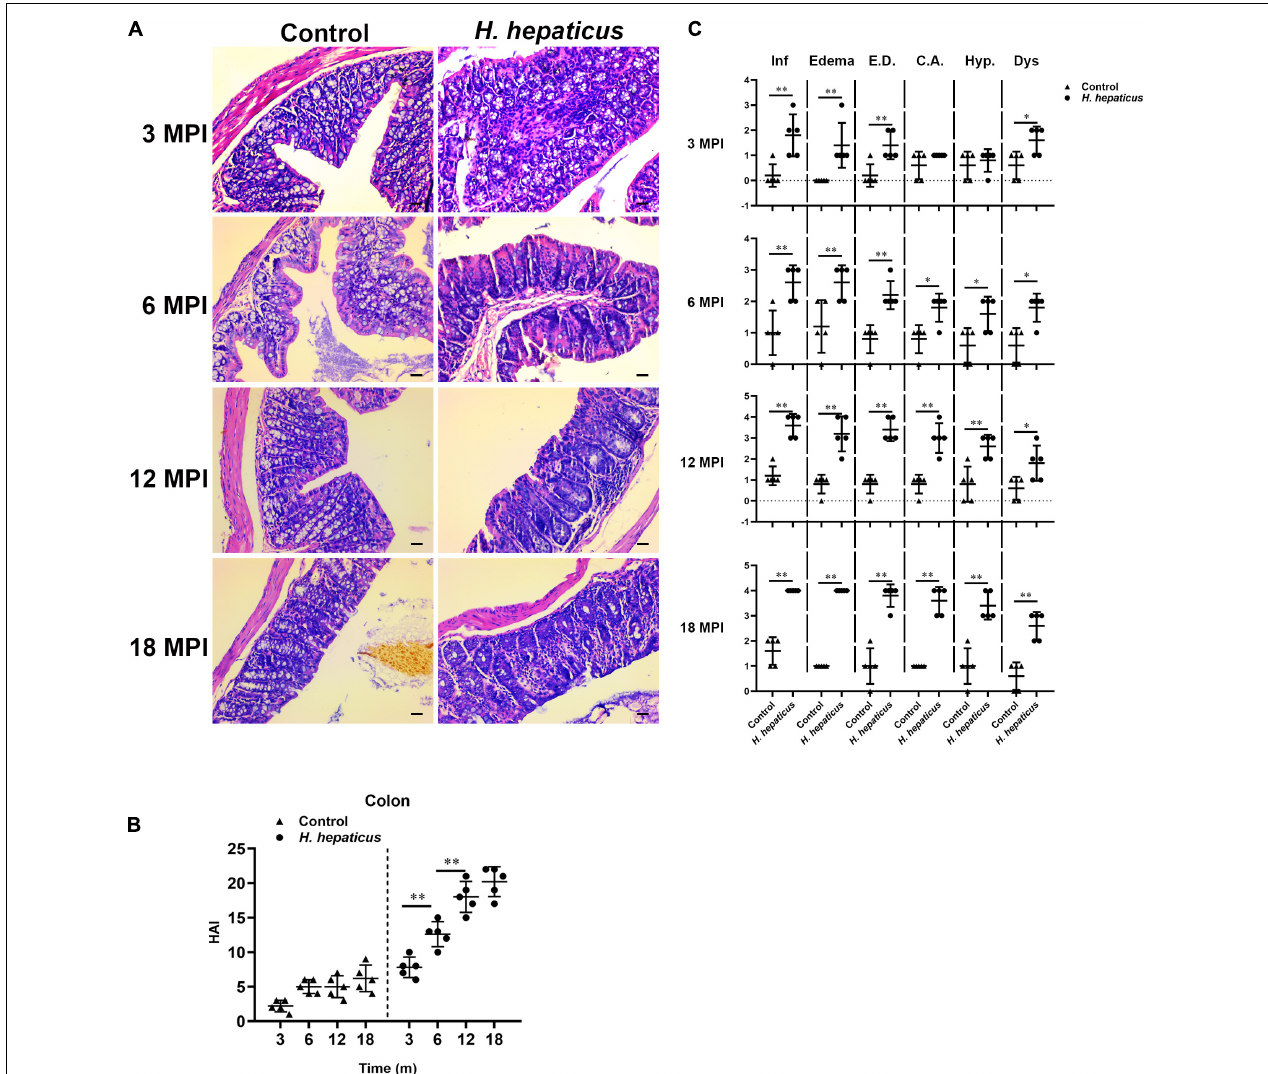
FIGURE 2 | Helicobacter hepaticus infection induced chronic colitis. (A) H&E images of the colon from male mice of control and H. hepaticus –infected groups at 3, 6, 12, and 18 months (magnification, × 200). (B) The intestinal histologic active index (HAI) was calculated by combining scores for all sub-categorical lesions of mice in the control and H. hepaticus –infected groups at all time points. (C) Scores of sub-categorical lesions in the colons in all representative mice at all time points. Data are expressed as the means ± SD ( n = 5). ∗ p < 0.05 as compared to the control, and ∗∗ p < 0.01 as compared to the control. Each group contained five